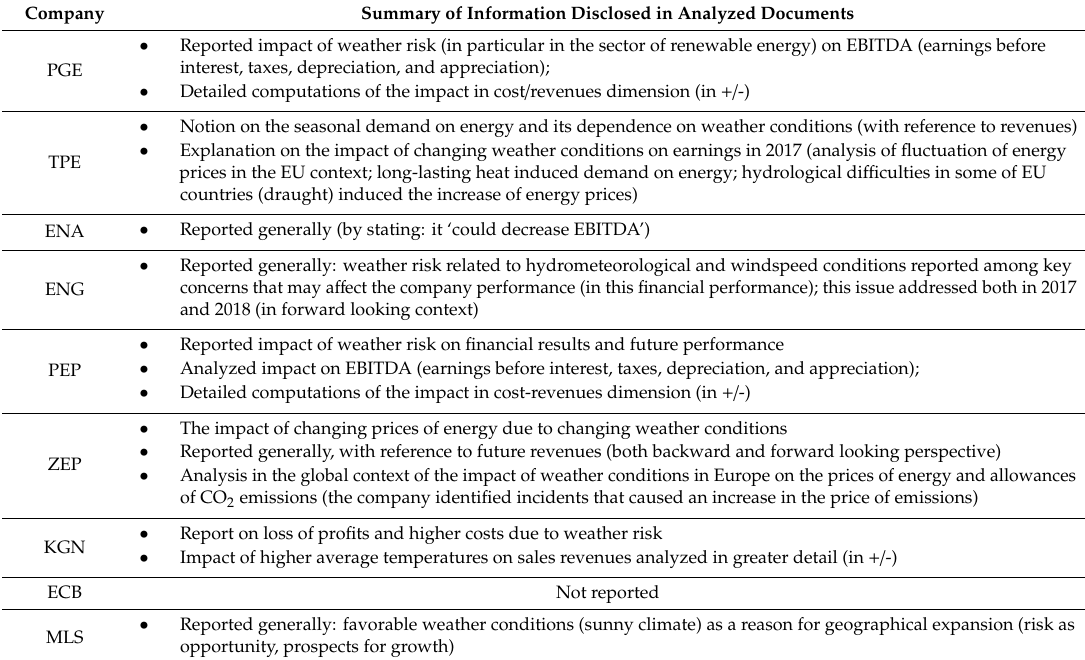
Table A3. Summary of textual data for RQ2: Does the company evaluate the impact of weather risk in cost-revenues dimension?